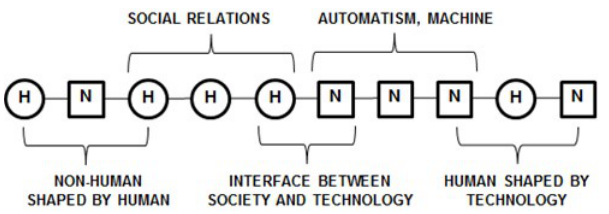
Fig. 2. Chains of associations in a heterogeneous social phenomenon. Rounded figures denote human actors, while squares represent the non- humans.